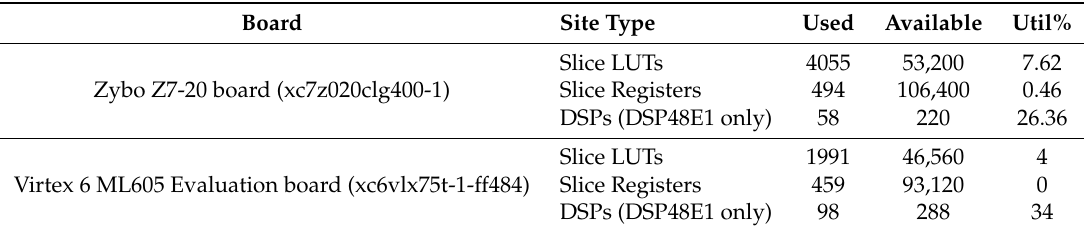
Table 3. Utilization results.